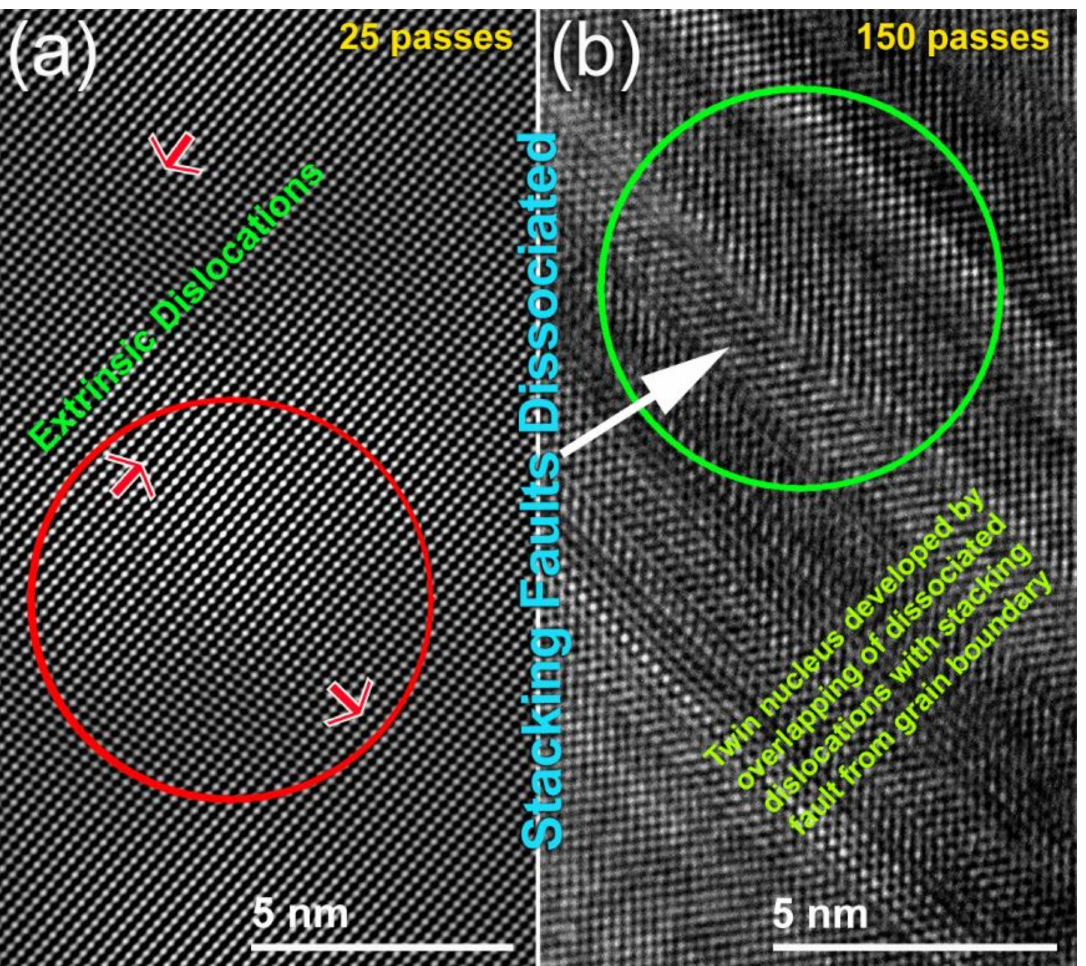
Figure 5. Atomic resolution FE-TEM images of Mg-ribbons after CR for ( a ) 25 passes, and ( b ) 150